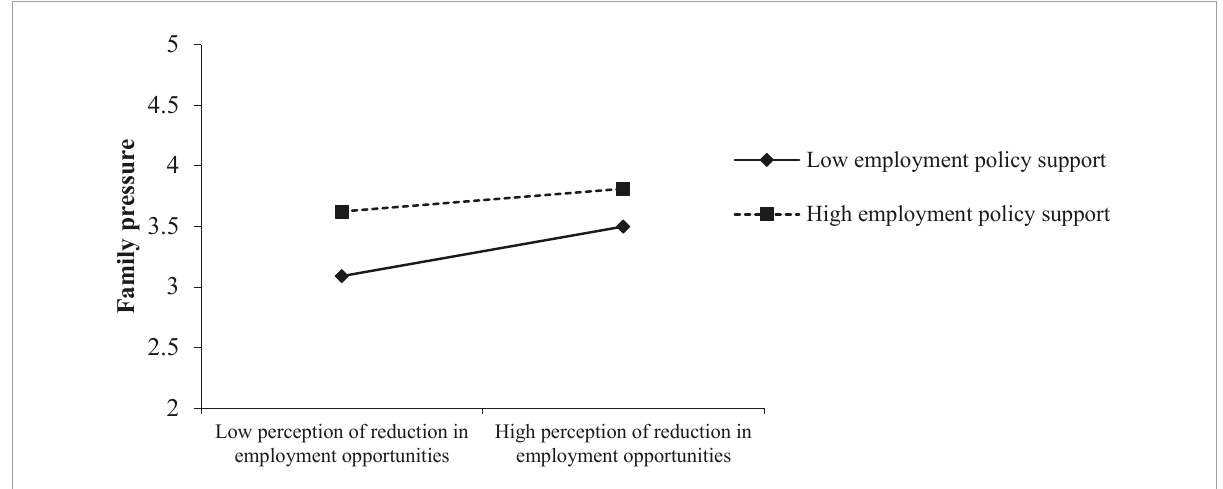
FIGURE5 The role of employment policy support in moderating the perception reduction of employment opportunities on the employment pressure of college students’ families.